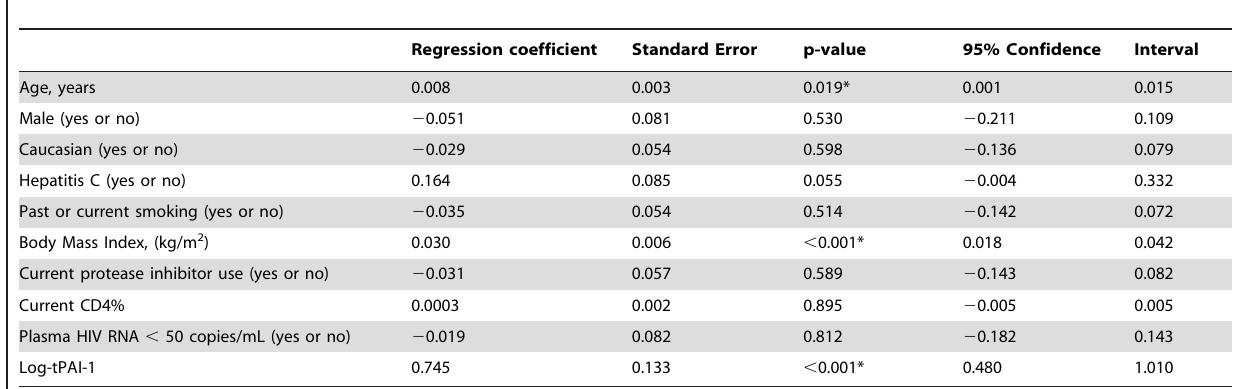
Table 3. Multivariate linear regression analysis of the relative contribution of tissue plasminogen activator inhibitor-1 (tPAI-1) to HOMA-IR adjusting for various HIV-associated and diabetes risk factors